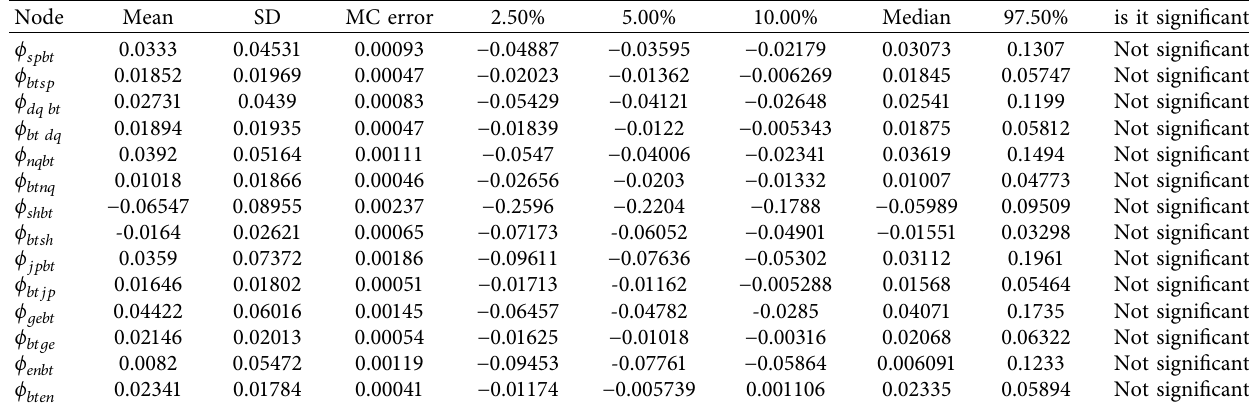
Table 5: Granger causality result between bitcoin and stock index.